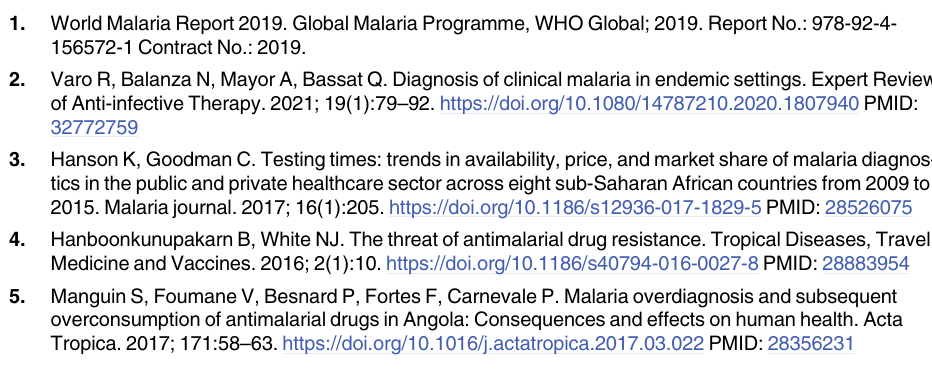
S2 Fig. High, medium, and low parasitemia images. Composite images from portable micro- scope showing smears with: (A) high 1% parasitemia, 833 cells, 13 parasites; (B) medium 0.1% parasitemia, 1005 cells, 4 parasites; (C) low 0.01% parasitemia, 833 cells, 2 parasites. The brightfield image from each was inverted and linearly contrast enhanced for clarity, and the fluorescent image overlay shows the segmented object pixels overlaid using the green image channel using FIJI ImageJ software. S1 Table. Costs of major components in portable microscope